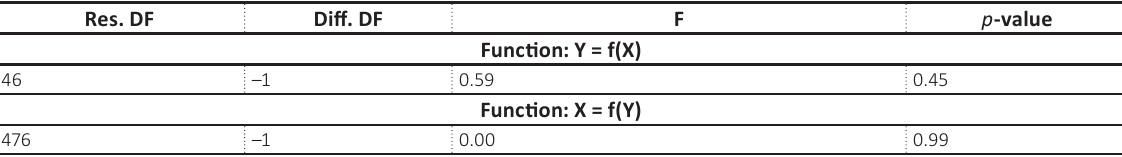
Table E6. SDGI rank 2016 (X) and non-government corporate ESG disclosure (Y) Res.